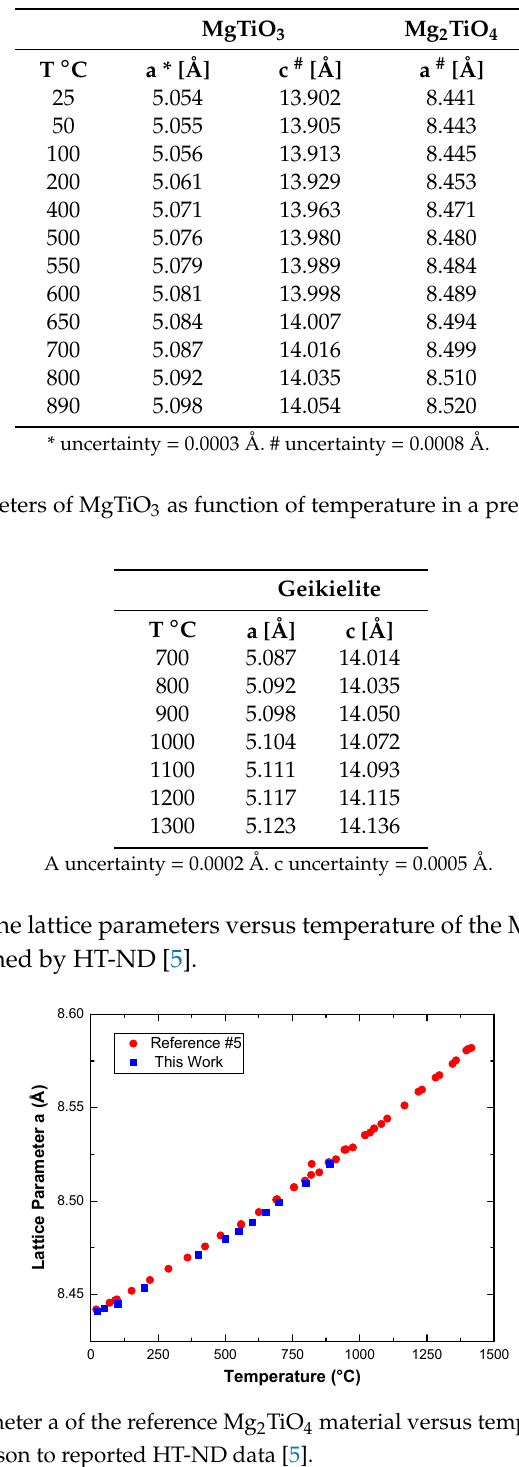
Table 5. Lattice parameters of MgTiO 3 and Mg 2 TiO 4 as function of temperature in the present investigation (sample GQ). All parameters are given in Å.